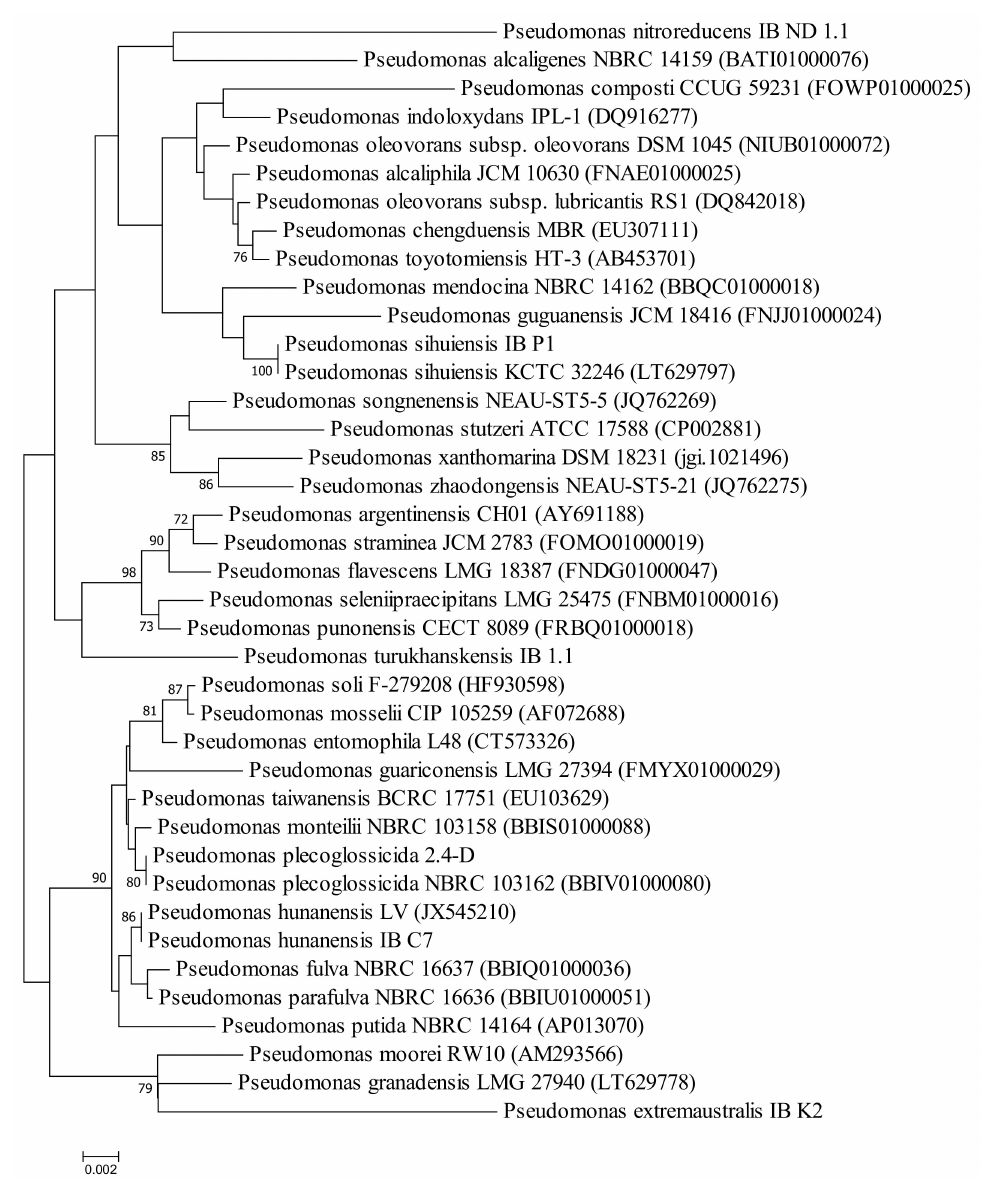
Figure 2. Neighbor-joining phylogenetic tree based on 16S rRNA gene sequences of the selected hydrocarbon-degrading bacteria and closely related species of the genus Pseudomonas . Bootstrap values (expressed as percentages of 1000 replications) are shown at the branching points. Bar—two nucleotide substitutions per 100 nt. Table 3. Auxin production (ng mL − 1 ) by bacterial strains cultivated on King B medium with di ff erent additives: oil, hexadecane and toluene (2 g L − 1 )